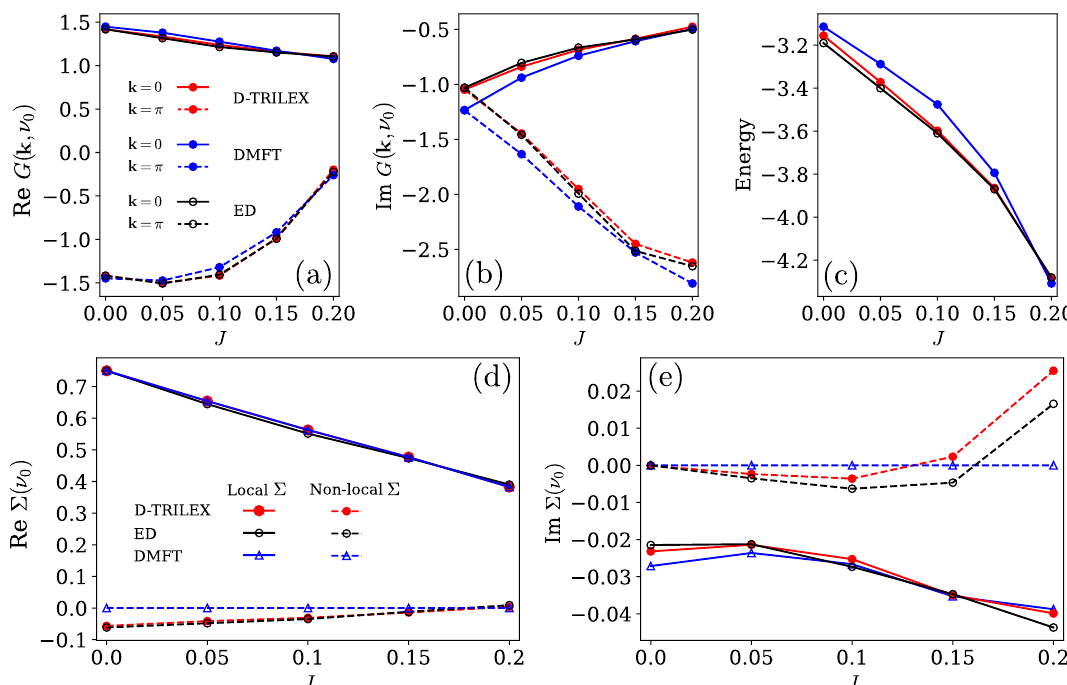
Figure 3: Panels (a) and (b) respectively show the real and the imaginary parts of the Green’s function for the Hubbard-Kanamori dimer calculated for the frequency ν = π/β at momenta k = 0 (solid line) and k = π (dashed line). The panel (c) 0 shows the average energy of the system. Panels (d) and (e) respectively show the real and the imaginary parts of the self-energy Σ for the frequency ν local component is denoted by a think line, while the non-local component is repre- sented by a dashed line. Non-local components are identically zero for DMFT, but are displayed for consistency. Results obtained using D-TRILEX (red), DMFT (blue), and ED (black) methods for different values of the Hund’s coupling J . Model param- eters for these calculations are t = 0.2, U = 0.5, β = 10, and µ = 0.75, and are equal across all